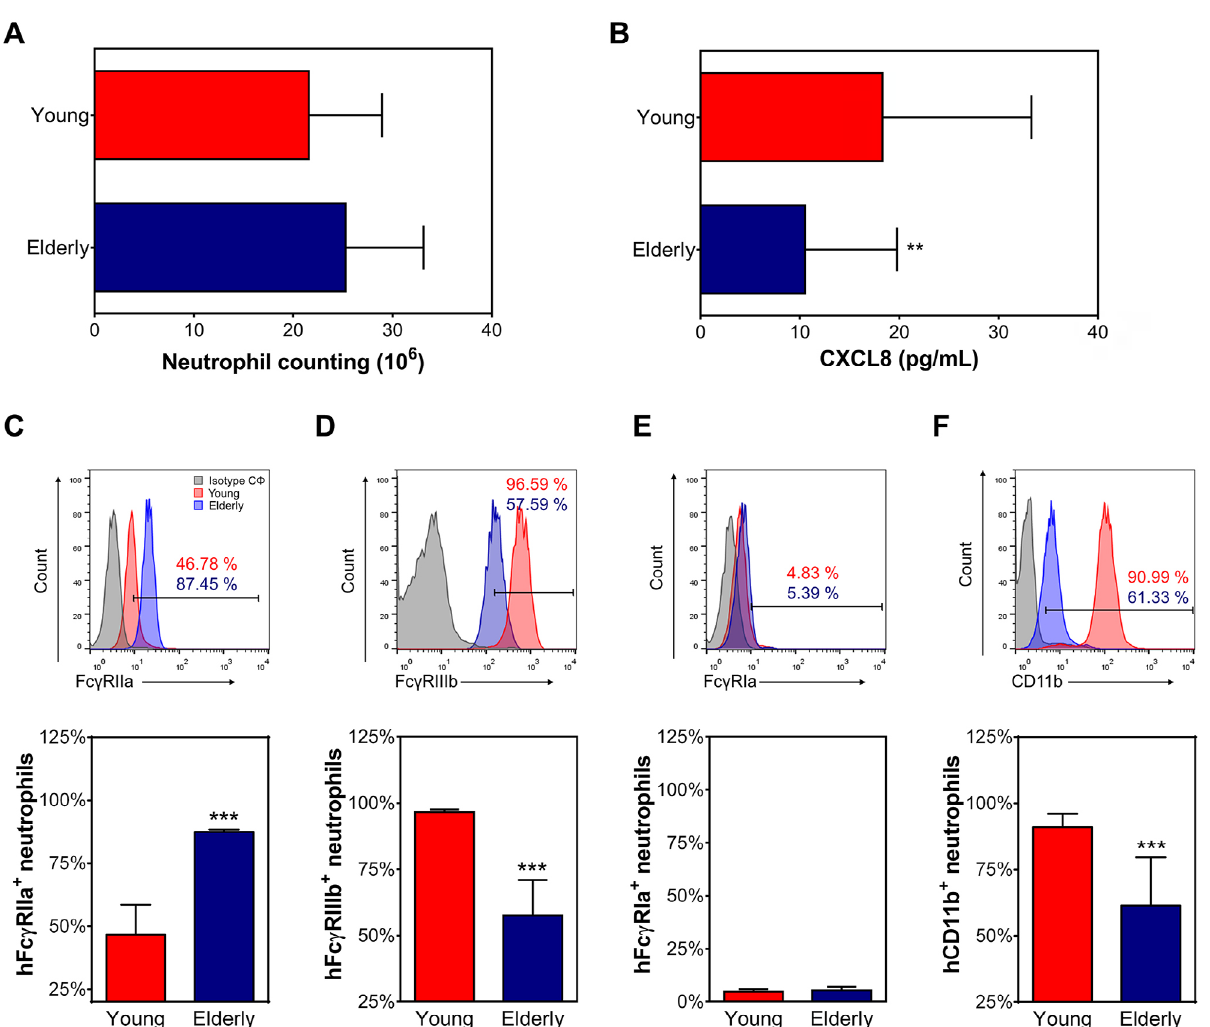
Figure 1- CXCL8 levels and expression of FcγRIIIb and CD11b on neutrophils from healthy elderly individuals are decreased. (A) Neutrophil counting and (B) CXCL8 levels from peripheral blood from healthy young (red bars) and elderly (blue bars) individuals. Representative histograms and respectively graphs showing the expression of (C) FcγRIIa, (D) FcγRIIIb, (E) FcγRIa, and (F) CD11b on purified ex vivo neutrophils from young (red bars) and elderly (blue bars) individuals determined by flow cytometry. Grey bars are relative to isotype controls. Data are presented as mean±SD. The results were evaluated by t-test. **p≤0.01 and